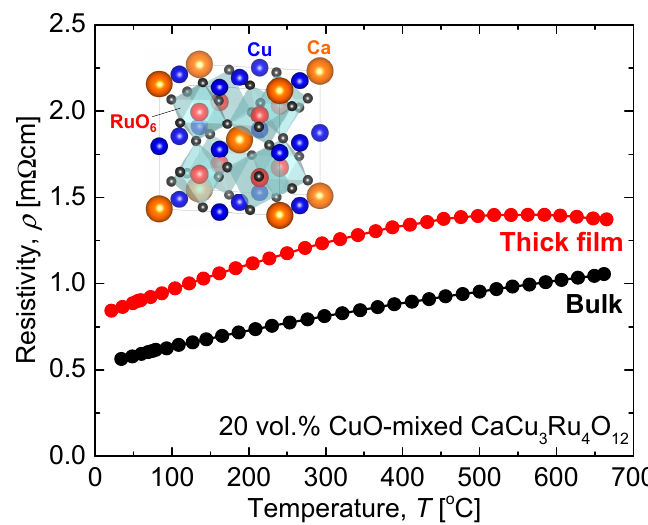
Figure 1. Temperature dependence of resistivity of 20 vol % CuO-mixed CaCu 3 Ru 4 O 12 bulk and thick film. The inset is the crystal structure of CaCu 3 Ru 4 O 12 . Table 1. Electrical resistivity at 500 °C ( ρ 500 ), TCR ( α 30–500 ), and material cost of Pt and CaCu 3 Ru 4 O 12 bulk [10].